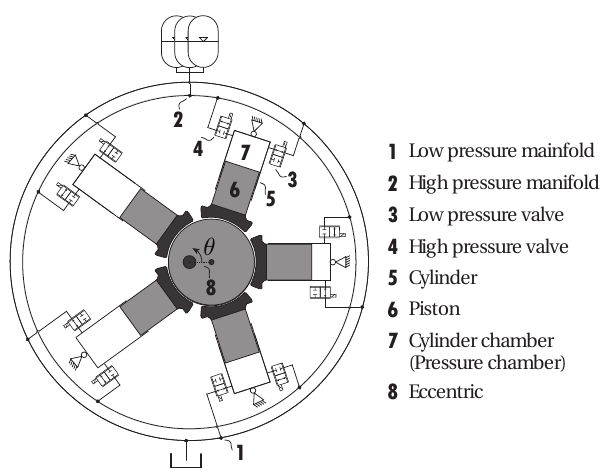
Figure 1: Illustration of the radial piston type digital displacement machine with 5 cylinders.